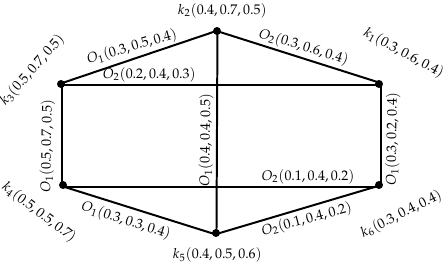
Figure 7. An INGS ˇ G i = ( O , O 1 , O 2 )